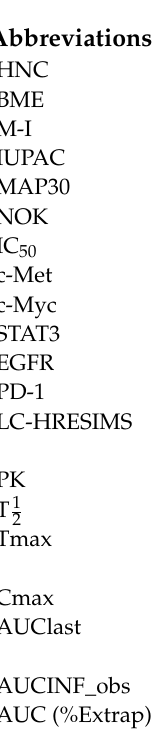
for Figure 2B, Figure S4: Whole blot for Figure 2C,D, Figure S5. Whole blot for Figure 3, Figure S6: Whole blot for Figure 6D, Figure S7: Whole blot for Figure